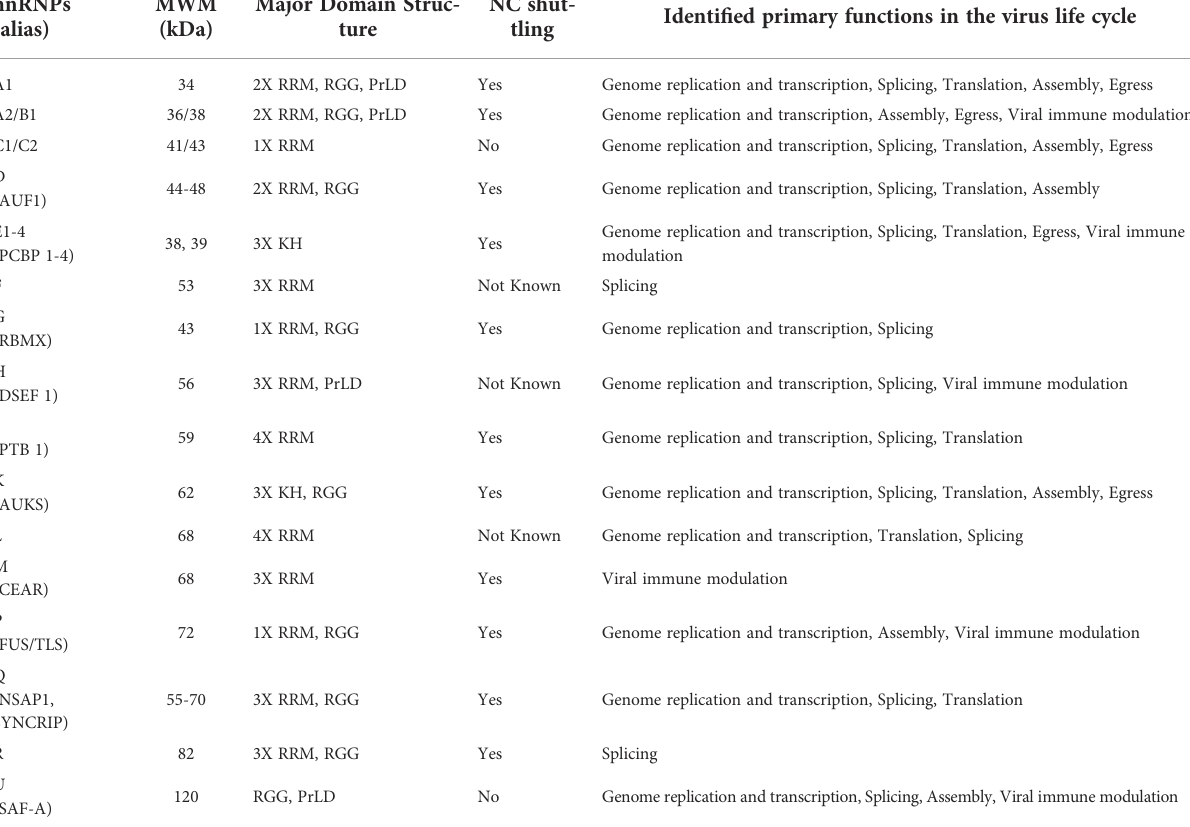
TABLE 1 Characteristics of major hnRNP